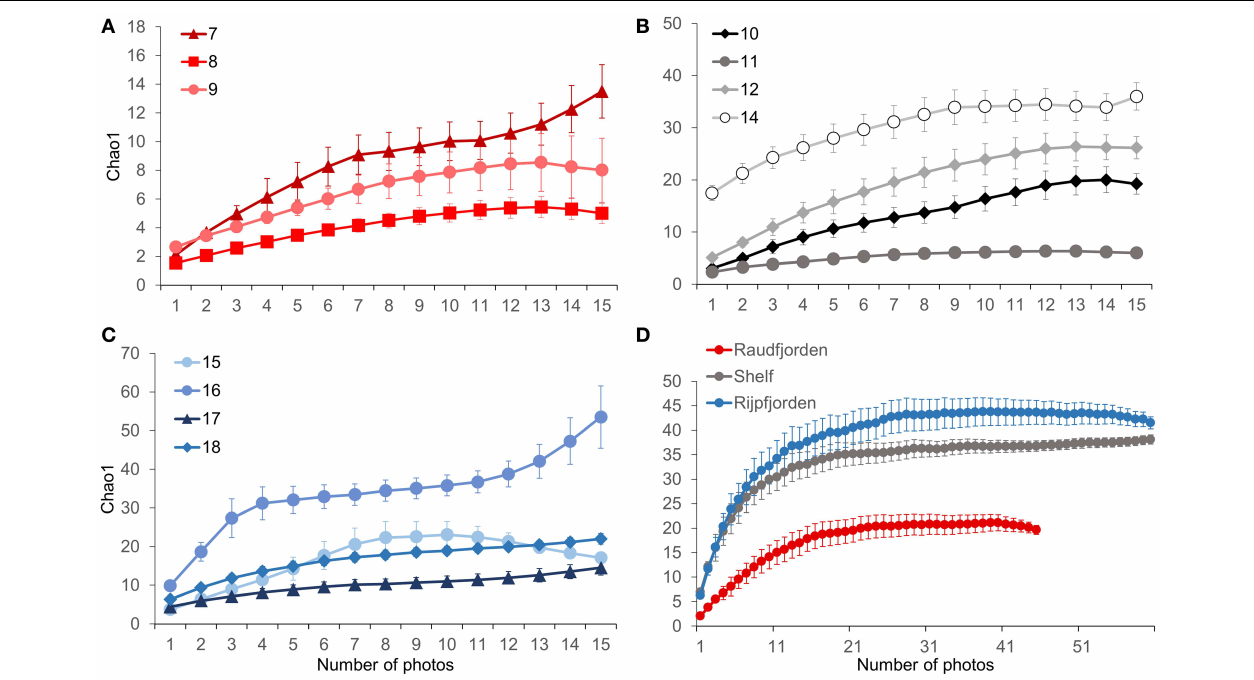
FIGURE 8 | dbRDA graph showing relationship of north Svalbard fauna to abiotic factors.